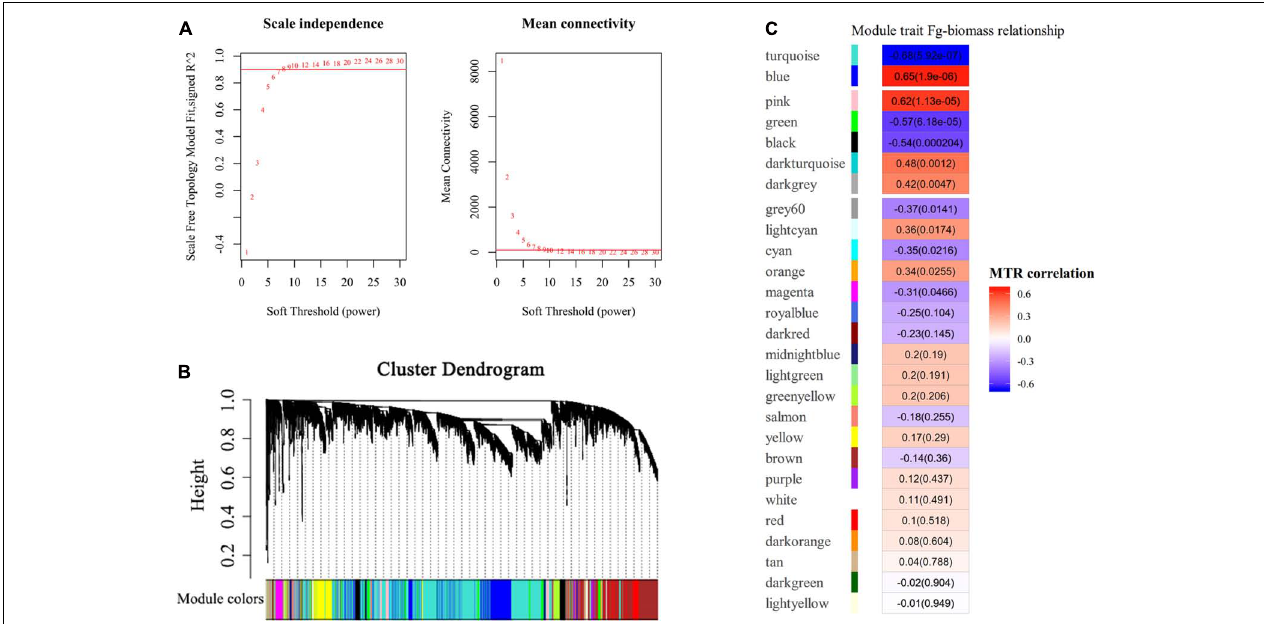
FIGURE 4 | WGCNA analysis of RNA-seq data. (A) Analysis of network topology for different soft-thresholding powers. The left panel indicates the influence of soft-thresholding power ( x -axis) on scale-free fit index ( y -axis), and the right panel shows the influence of soft-thresholding power ( x -axis) on the mean connectivity (degree, y -axis). The approximate scale-free topology can be attained at the soft-thresholding power of 8. (B) Gene clustering dendrograms of DEGs, with dissimilarity based on consensus topological overlap, together with assigned module colors indicated by the color row. Each colored row represents a color-coded module, which contains a group of highly connected genes. A total of 27 modules were identified. (C) Relationships of consensus module eigengenes and fungal biomass of F. graminearum . Each row in the table corresponds to a consensus module shown on the left side of each row. Numbers in the table indicated the correlations of the corresponding module eigengenes and fungal biomass trait, with the p values shown in parentheses. The table is color coded by correlation according to the color legend. Intensity and direction of correlations are indicated on the right side of the heatmap, in which red indicated positively correlated and green indicated negatively correlated. MTR, module–trait relationship.